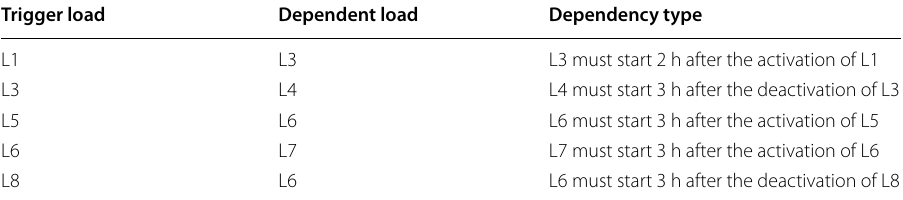
Table 7 Characteristics of dependencies in use case III Trigger load